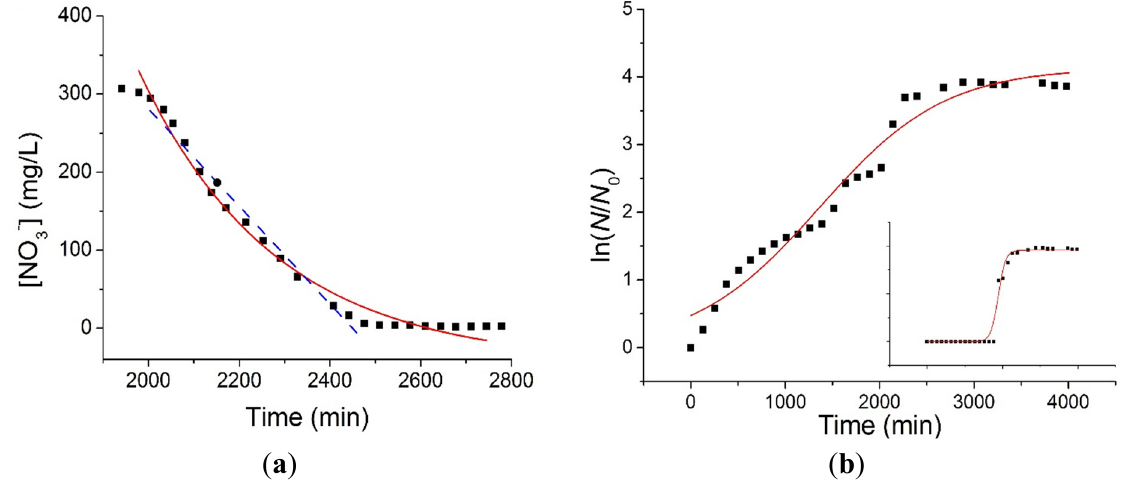
Figure 4. ( a ) Exponential fitting (red line, Equation (3)) and linear fitting (blue dashed line, Equation (2)) of the [NO 3 − ] consumption during the exponential period; ( b ) Fitting of the bacterial growth curve by means of the logistic Equation (4). The inset shows the bacterial growth curve when the bacterial population is considered constant during the acclimation